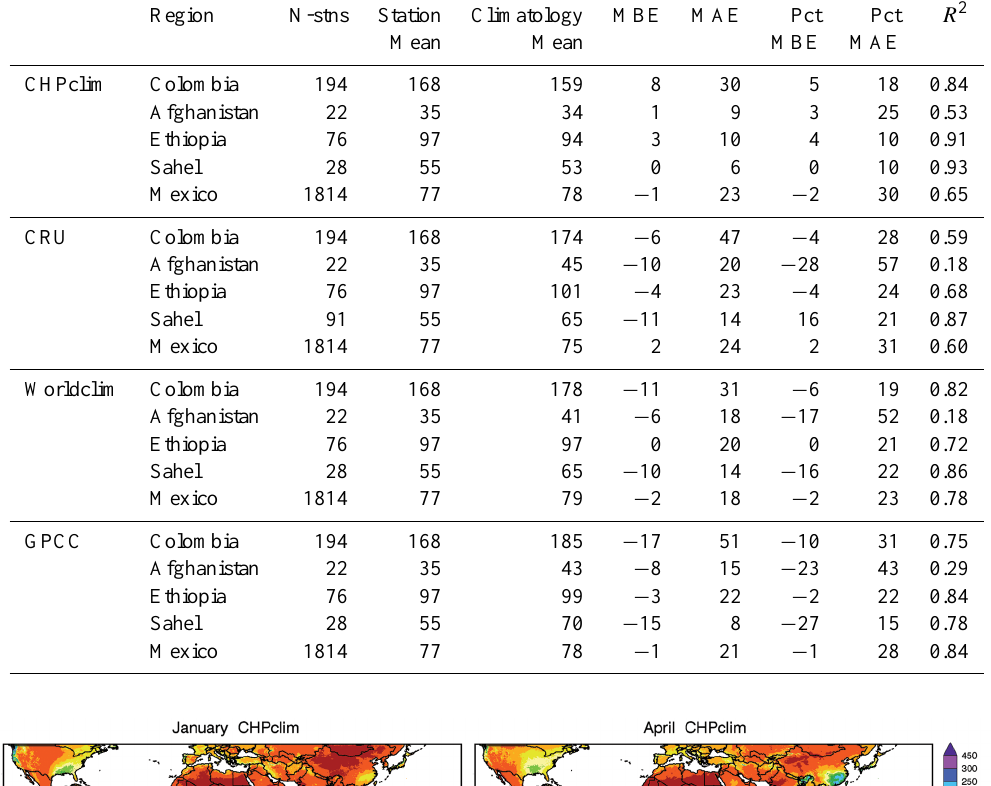
Table 1. CHPclim validation results.